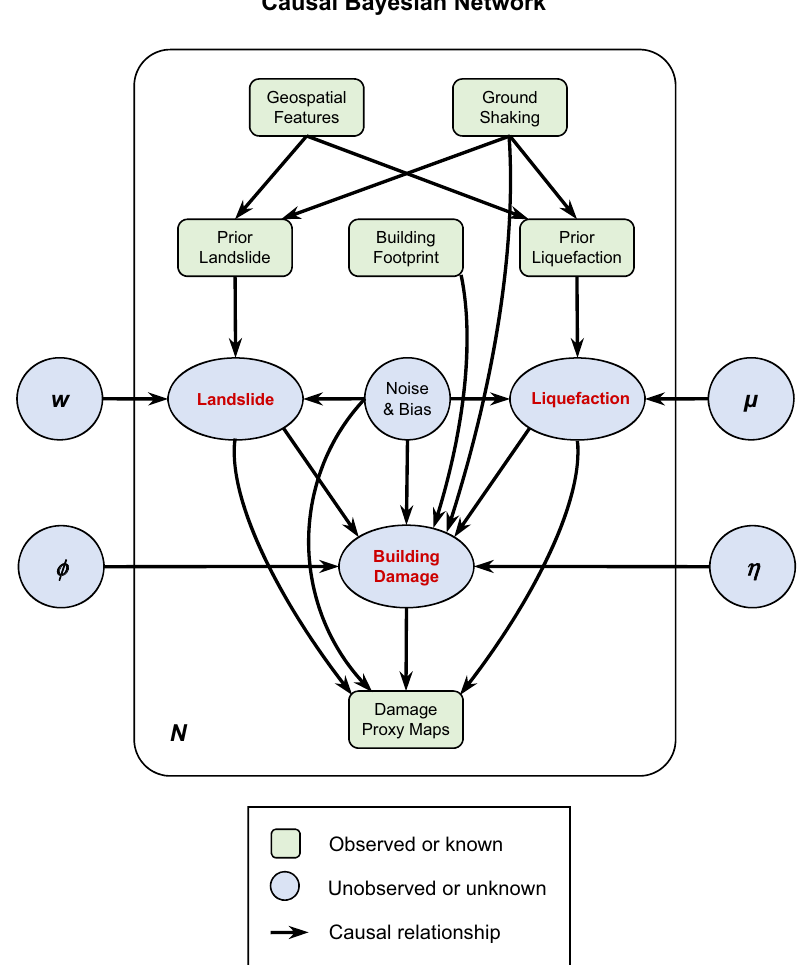
Fig. 1 | Causal Bayesian network that depicts causal dependencies among dif- ferent seismicground failures,building damage, Damageproxy maps(DPMs), and environmental noises. N refers to N locations/pixels in the target area. The posterior probability of landslide, liquefaction, and building damage at each loca- tionaretheobjectivesthatoursystemestimates.Greenboxesrefertothevariables